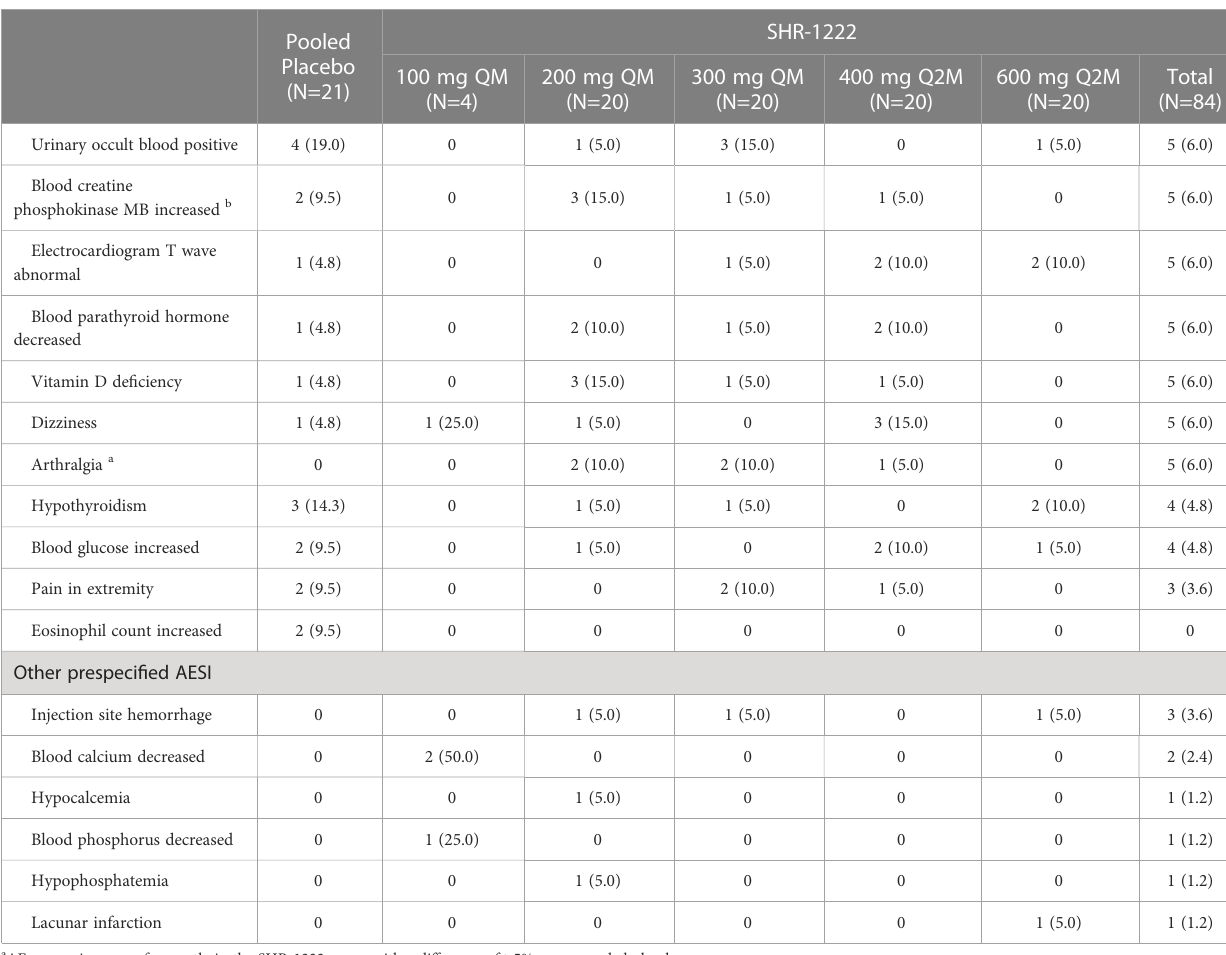
The PK parameters are summarized in Table 3 and the plasma concentration-time curves are shown in Figure